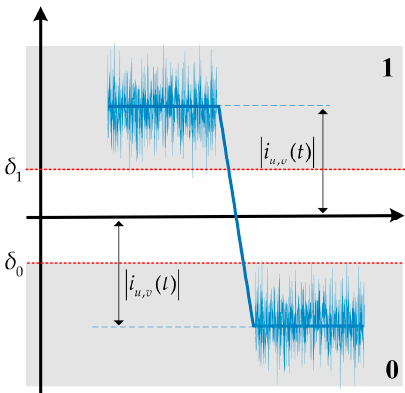
Figure 5. Schematic diagram of the 0–1 judgment. δ 1 and δ 0 here are the set thresholds for the